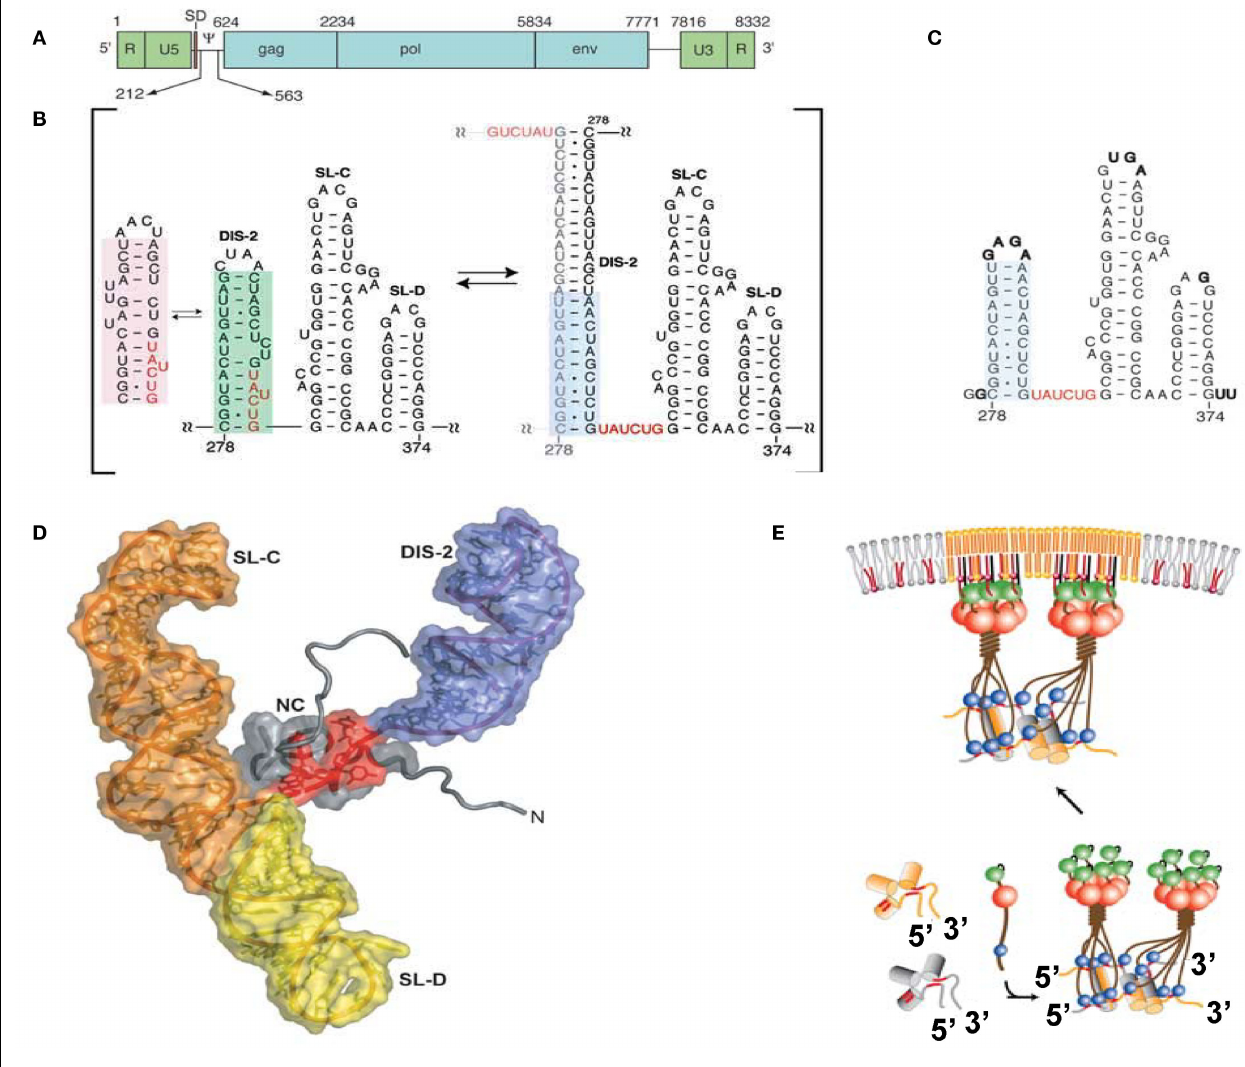
MoMuLV. Upon dimerization, SL–CD exhibits a cross-kissing interaction, promoting the proximity of NC-binding sites.The SL–CD dimer functions as